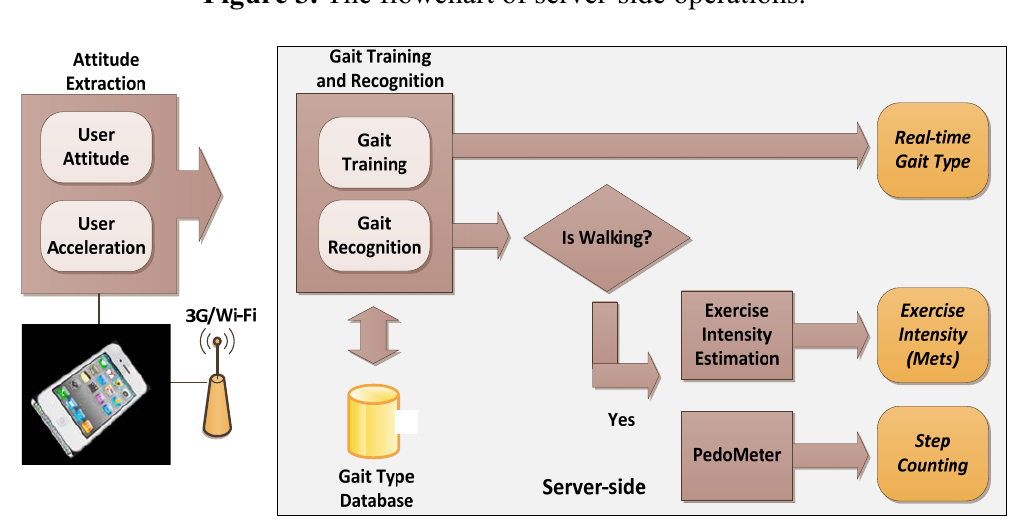
Figure 3. The flowchart of server-side